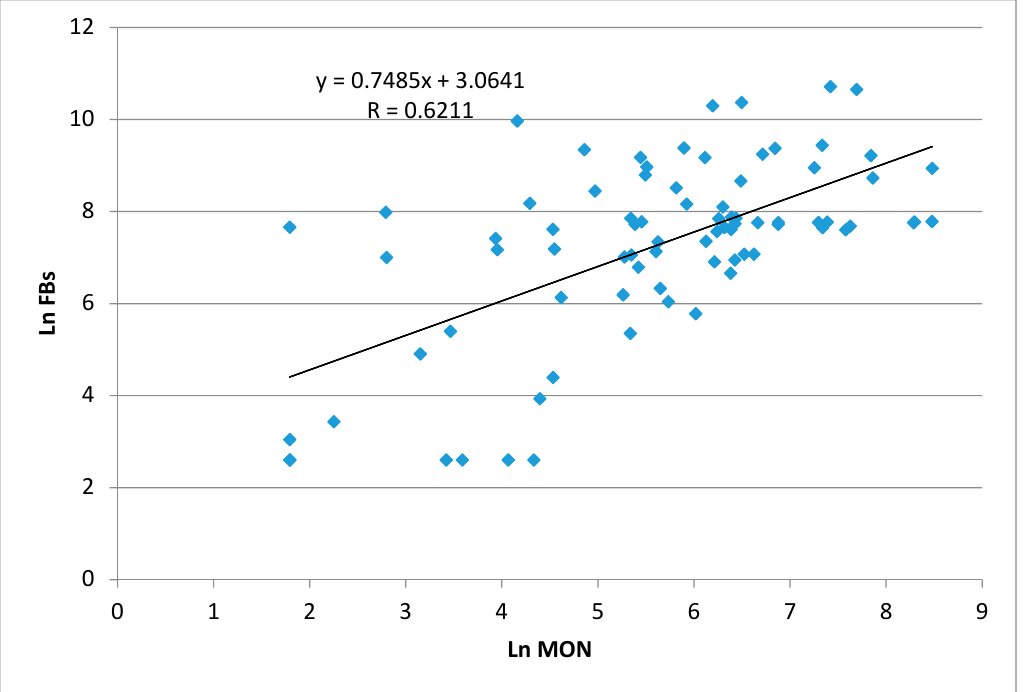
Figure 3. Correlation between moniliformin (MON) and fumonisins (FBs) in maize samples. Data were ln transformed.